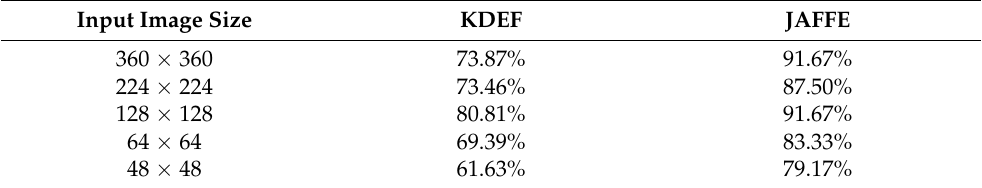
Table 1. Test set accuracies of standard CNN with two layers on KDEF and JAFFE datasets for different input size